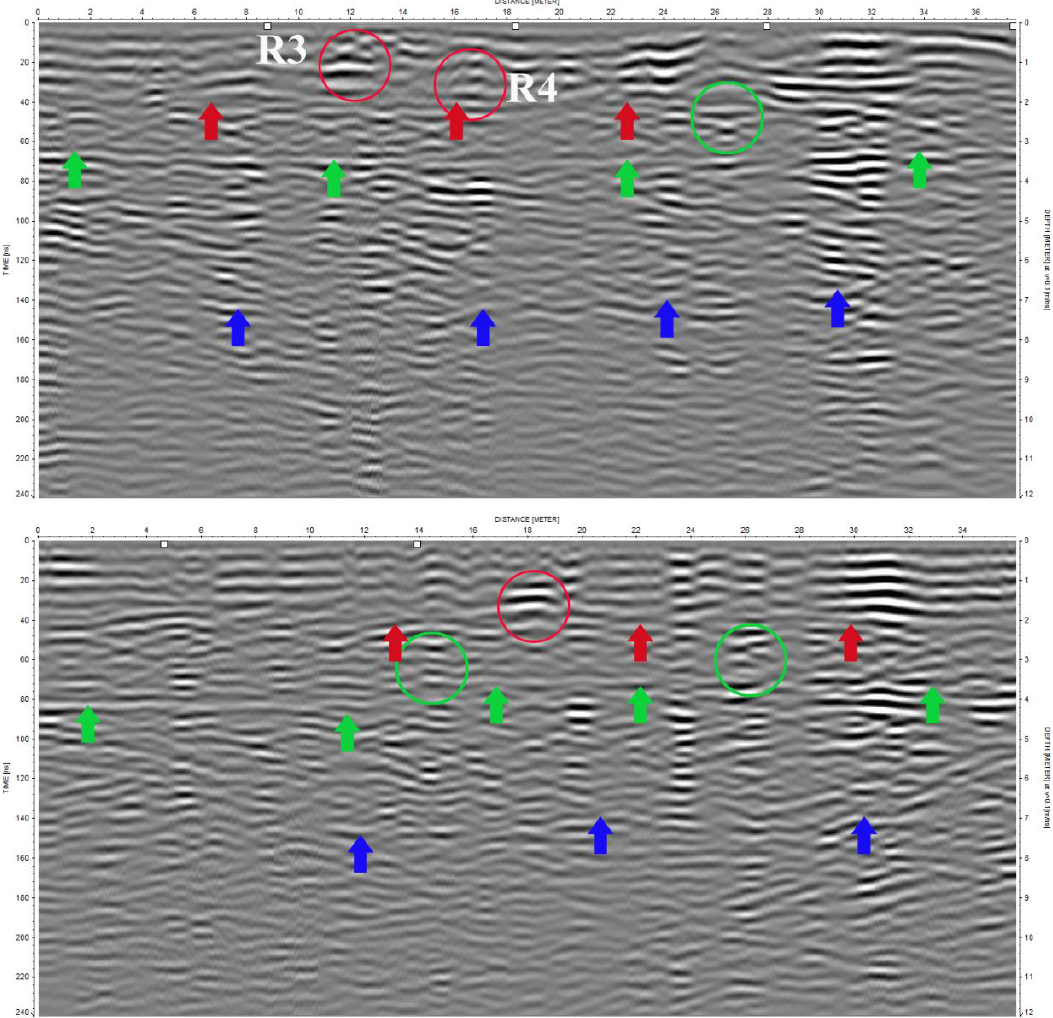
Figure 9. 100 MHz radargrams placed respectively at 6 ( up ) and 12 ( bottom ) meters from the origin of the investigated area. The red arrows indicate the interface related to Qing Dynasty phase at around 2 m respect to level of investigated area. Green arrows denote the floor of Ming Dynasty phase. Blue arrows could likely refer to Yuan or Jin Dynasty. Finally, red and green circles indicate local reflector referable to buried walls or artifacts inside the Qin and Ming Dynasty layers, respectively.